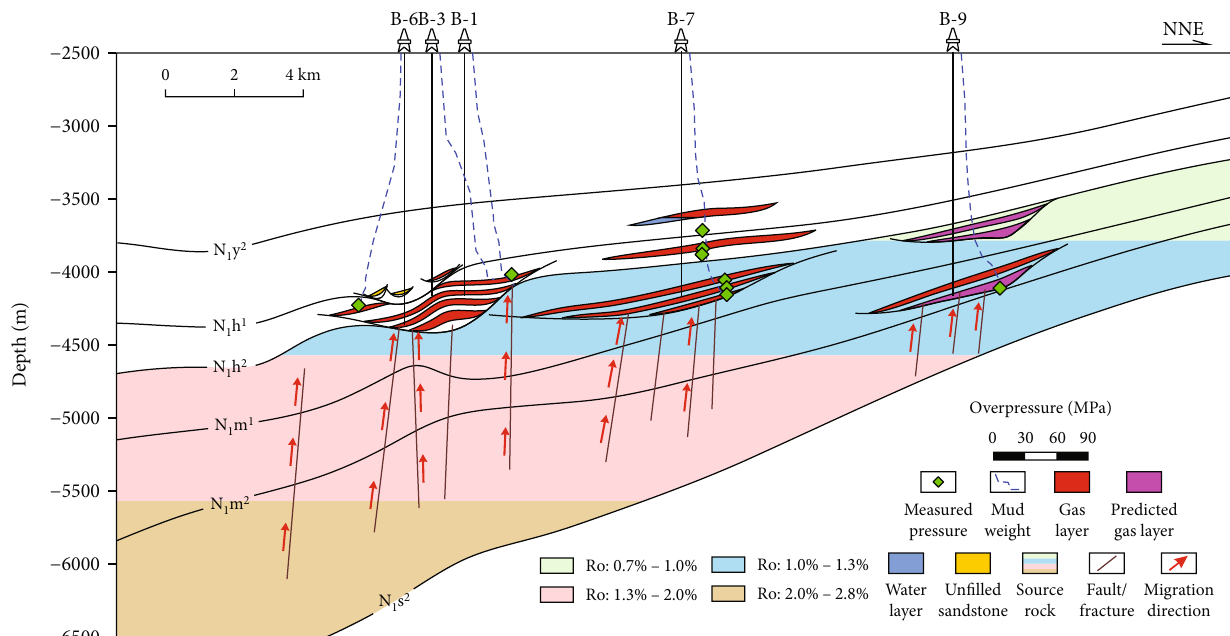
Figure 13: Model of the migration of natural gas and the process of overpressure vertical transfer in the LD-B